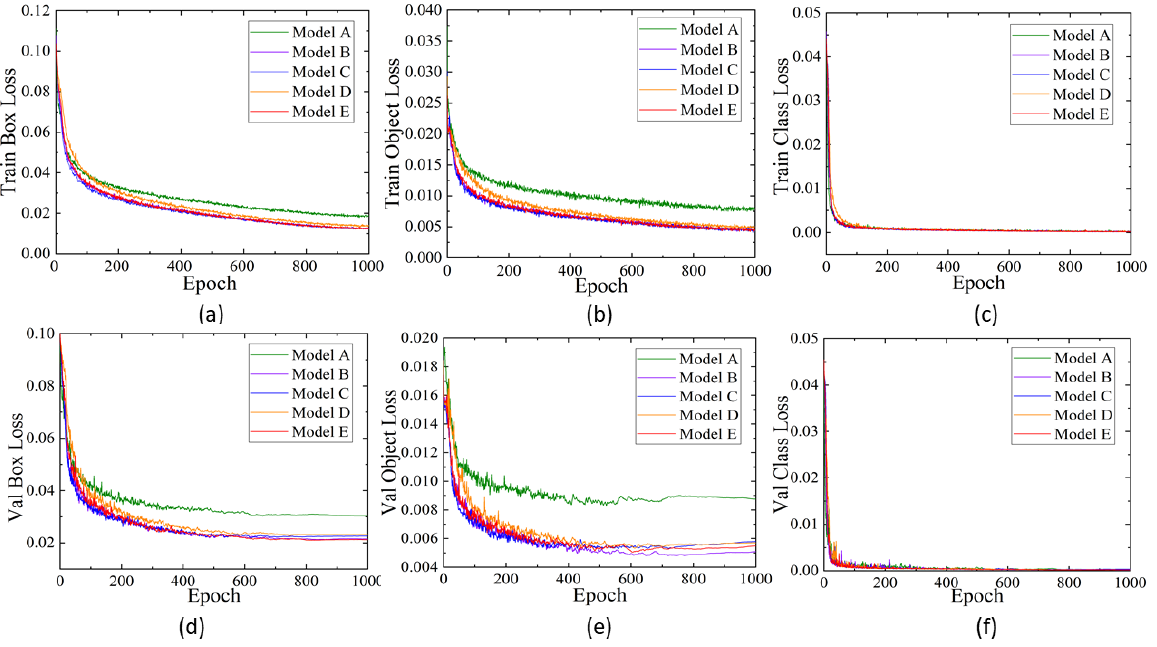
Figure 8. The learned loss functions of different models in the TLDPSD-2022 training set. ( a ) Train Box loss; ( b ) Train Object loss; ( c ) Train Class loss; ( d ) Val Box Loss; ( e ) Val Object Loss;( f ) Val Class Loss.